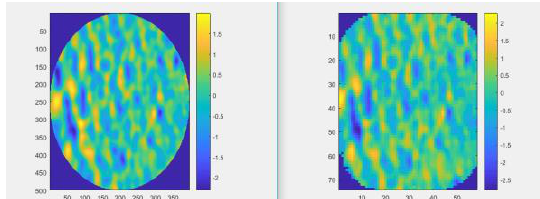
Figure 5 . In-process deflectometry and UA3P data for lightweight monolith freeform